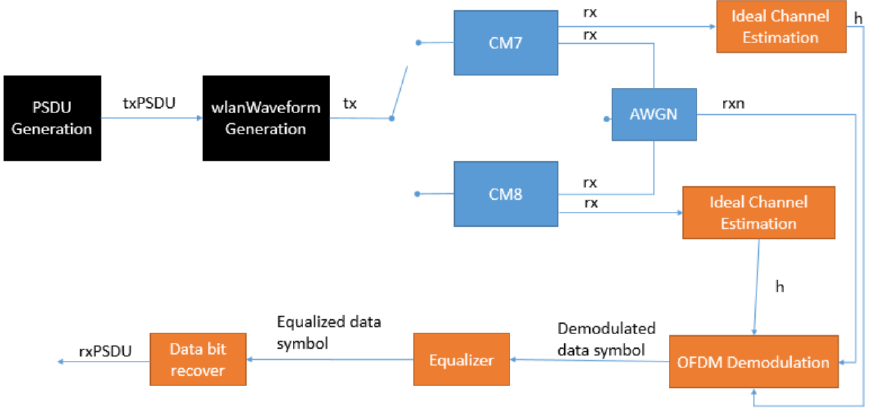
Figure 2. Block diagram model for reliability